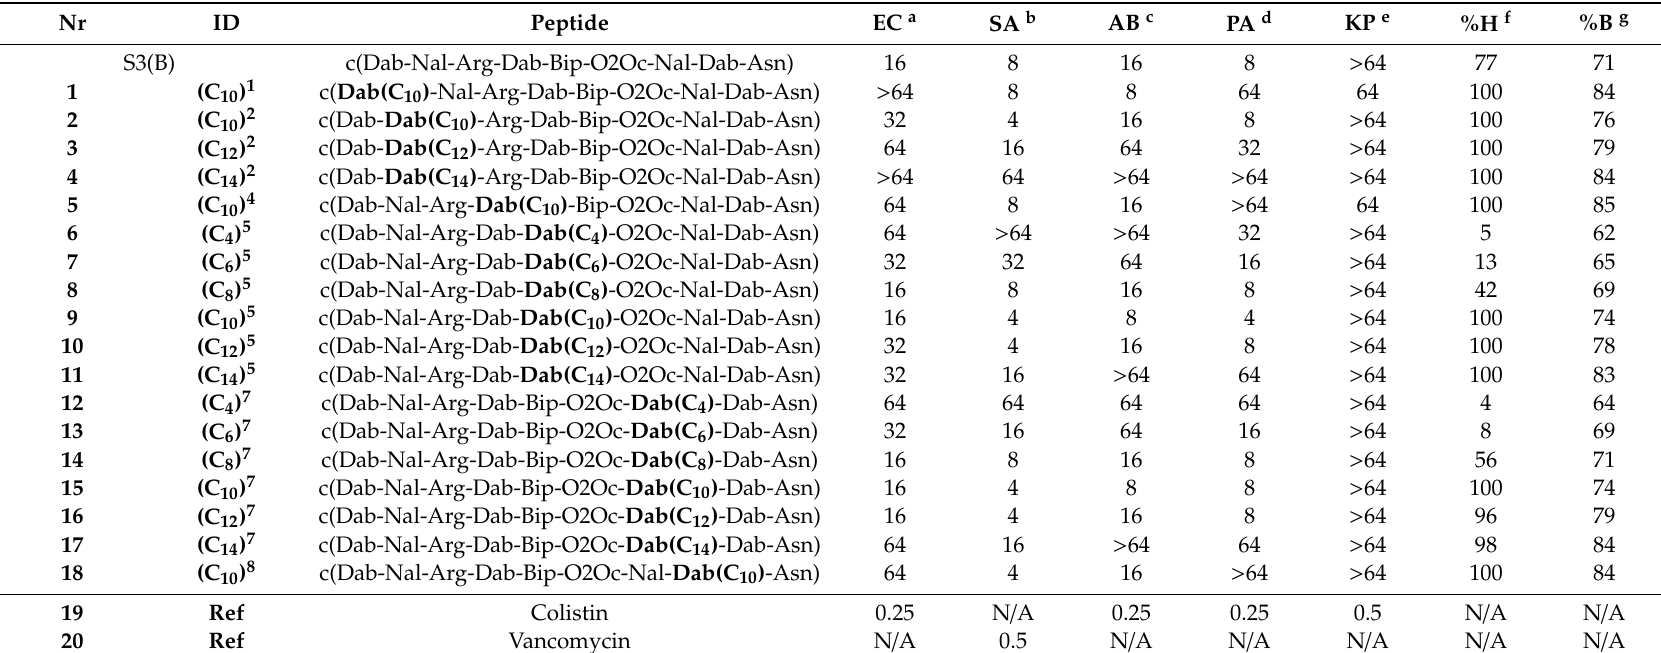
Table 1. Minimum inhibitory concentration values ( µ g /